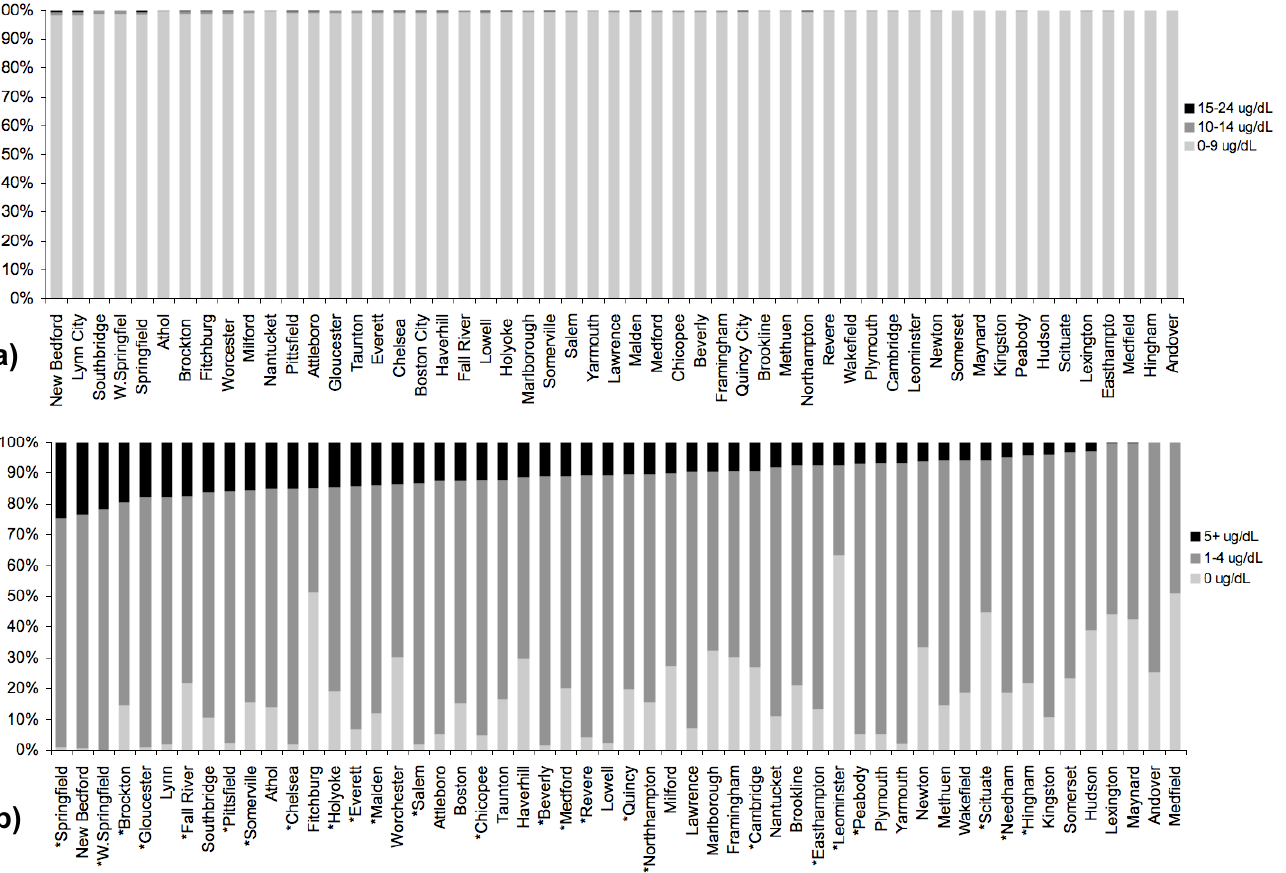
Figure 1. Distribution of BLLs by MA community for children aged 9–47 months in